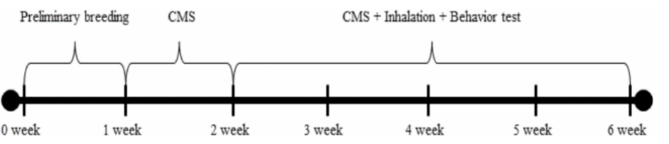
Figure 1. The plan of the animal study showing a week of preliminary breeding, a week of chronic mild stress (CMS), and four weeks of CMS + inhalation + behavior